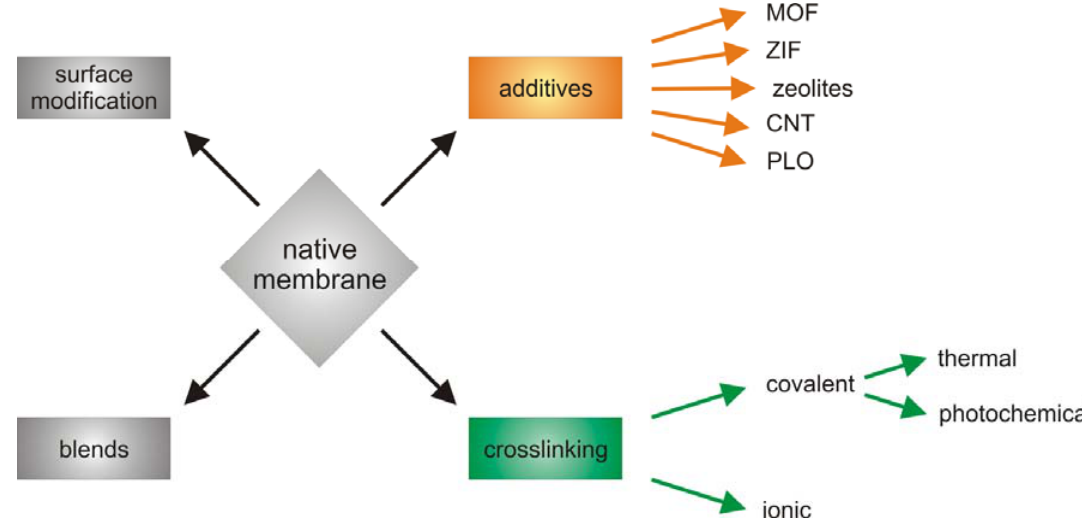
Figure 2. Different approaches to improve polymeric membrane